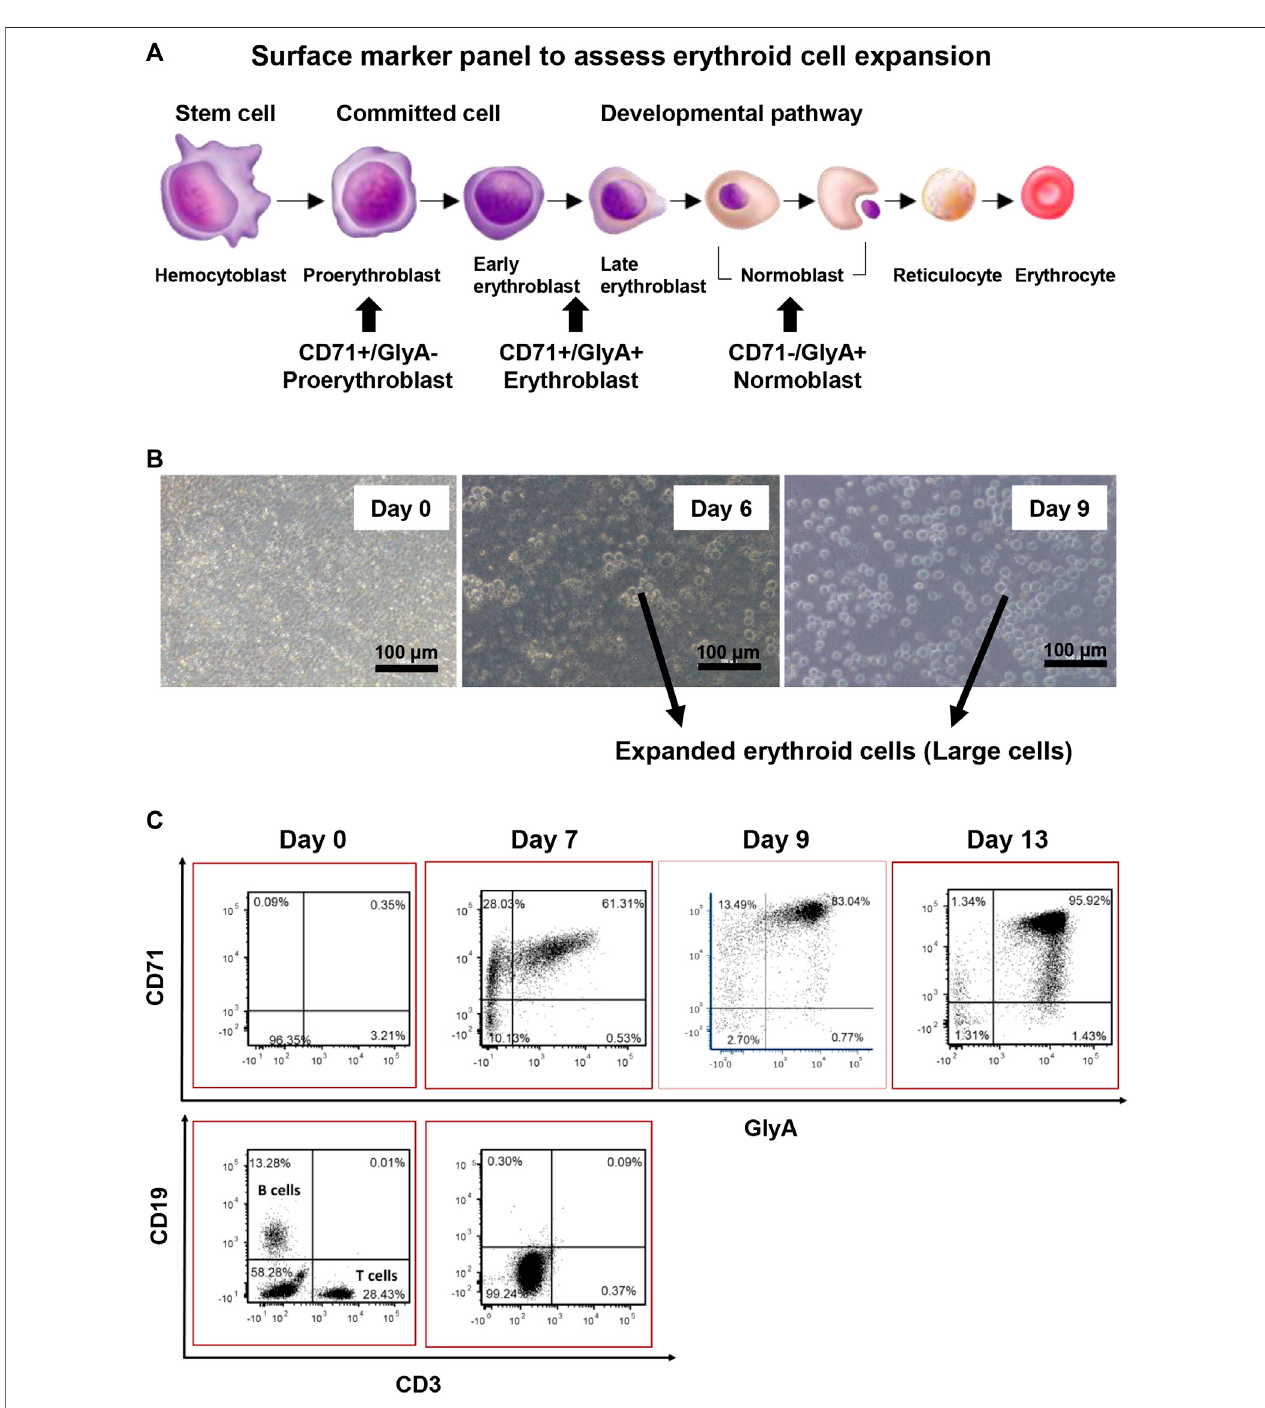
FIGURE 2 | Characterisation of erythroid cell expansion. (A) Panel of Surface markers chosen for assessing erythroid cell expansion. (B) Expanded erythroid cells arelargerinsizecompared withtheinputMNCs. (C) 2Dplotoferythroidcellexpansion.Theerythroidcellculturesshouldnotexceed9daysascellsproceedtobecome